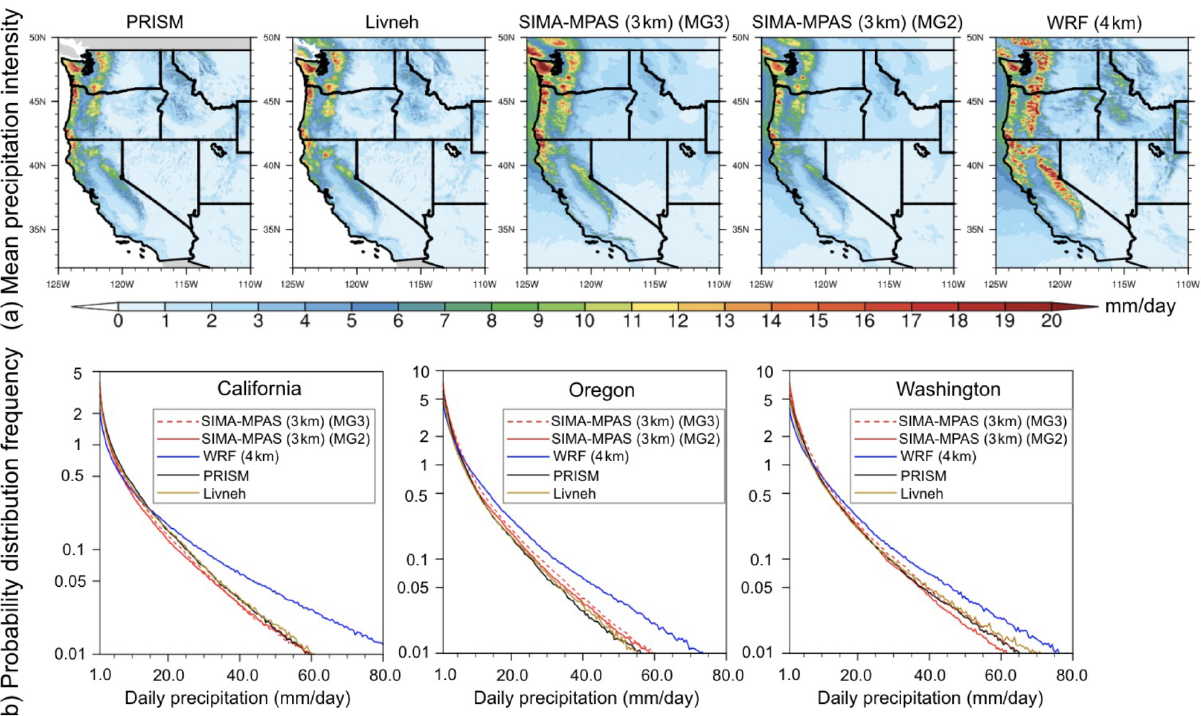
Figure 6. MG2 vs. MG3 microphysics used in SIMA-MPAS for the wet-season precipitation over the western USA (1999–2002). (a) Mean precipitation intensity; (b) probability distribution of daily precipitation frequency, like Fig. 5 but for three wet seasons with SIMA-MPAS (MG3) added in dashed red lines; again, the SIMA-MPAS model data are regridded to the same resolution as the PRISM grid spacings (i.e.,